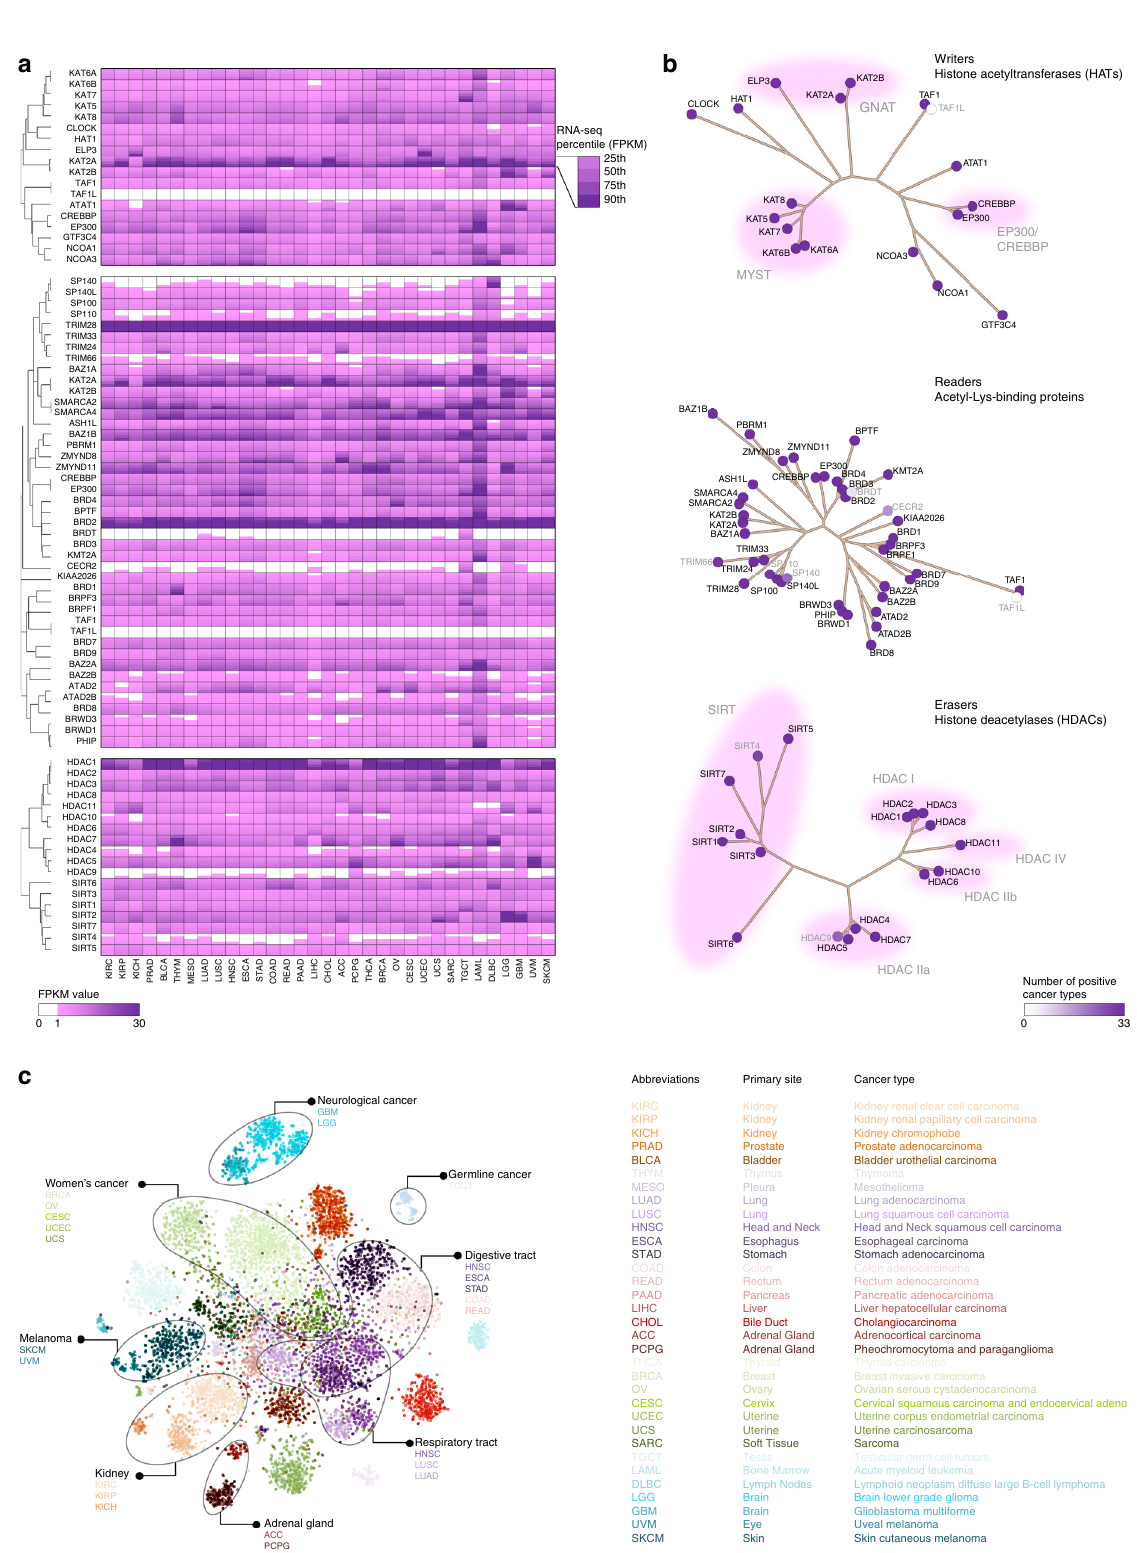
(Fig. 2b and Supplementary Figure 2). Importantly, only six HAMPs had both recurrent copy number gain and loss in different types of tumors. Most HAMPs were consistently altered (either gain or loss) across different cancer types, suggesting that these HAMP SCNAs are not merely the result of genomic instability but may functionally contribute to tumor development. Notably, most identi fi ed focal regions contained multiple genes